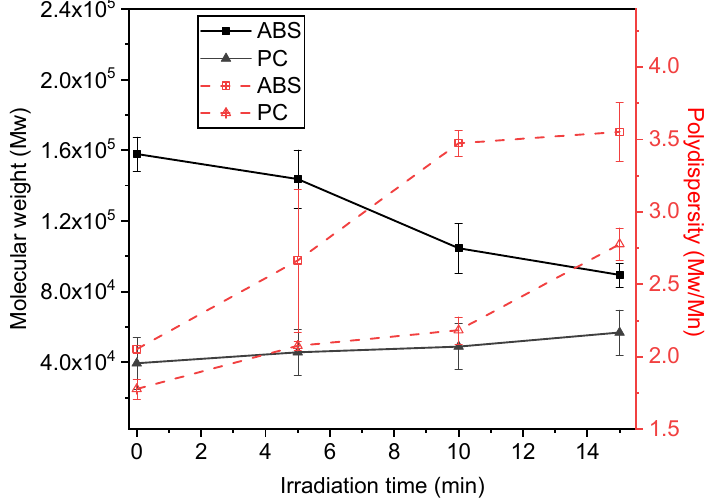
Figure 9. GPC results: Evolution of molecular weight and polydispersity of ABS and PC from 90 wt-% ABS/10 wt-% DBDE and 90 wt-% PC/10 wt-% DBDE films as function of irradiation time.